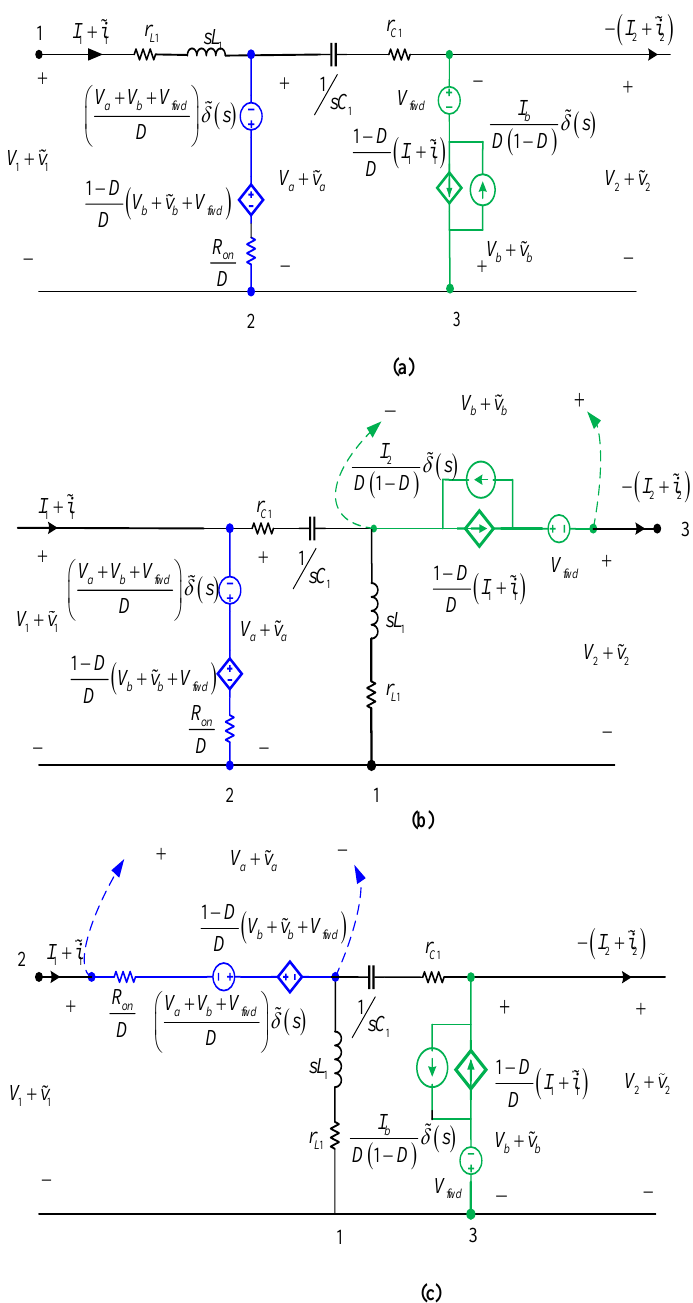
Figure 9. Rail connection variants for the non-ideal lumped Type 2 BBBs. ( a ) Switch and diode to rail, ( b ) inductor and switch to rail, and ( c ) inductor and diode to rail.